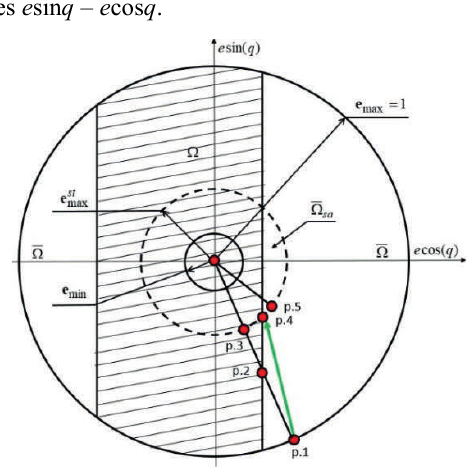
Fig. 3. The resonant zone in coordinates e sin q − e cos q . In this case, the allowable storm area is limited by this side st e ; st e crosses two boundaries of of the resonant zone Ω and max max the resonant zone Ω . In this case, there are two permissible